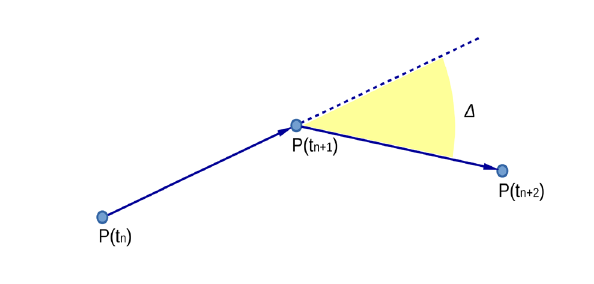
Figure 7. Trajectory categorization